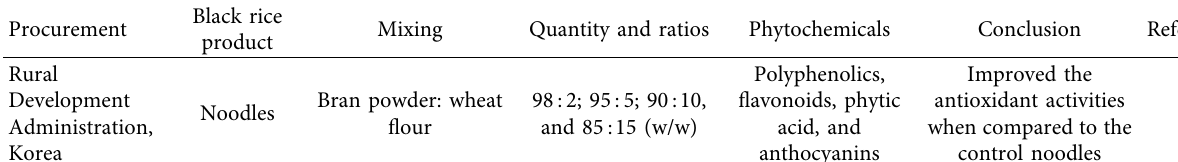
Table 2: Food applications of black rice and their